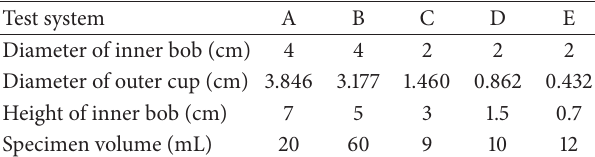
Table 3: Test systems of NXS-11B type rotational rheometer.